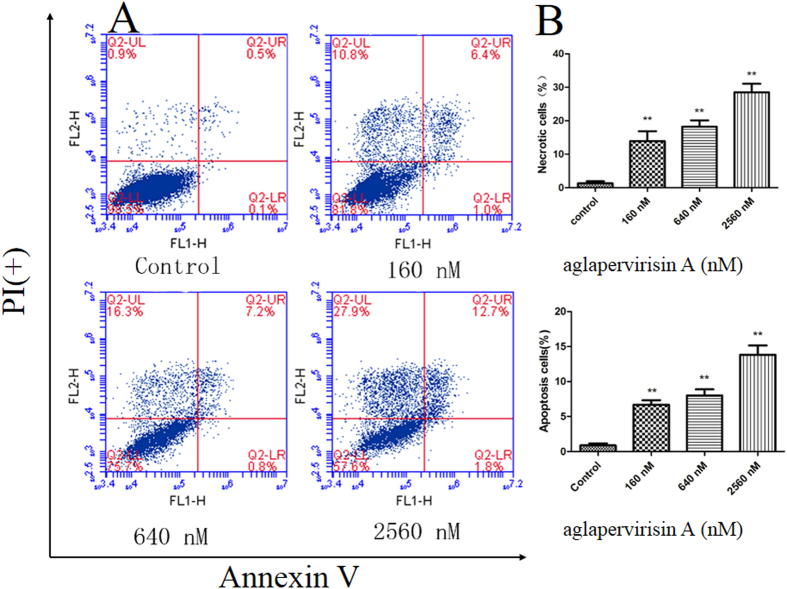
Analysis of apoptosis in 1-treated HepG2 cells.(A) The cells were treated with 1 at 160 nM, 640 nM or 2560 nM for 72 h. (B) The numbers of apoptotic cell were calculated by flow cytometry. Data are presented as the means ± SD of three experiments. *P < 0.05, **P < 0.01 compared to the control group.